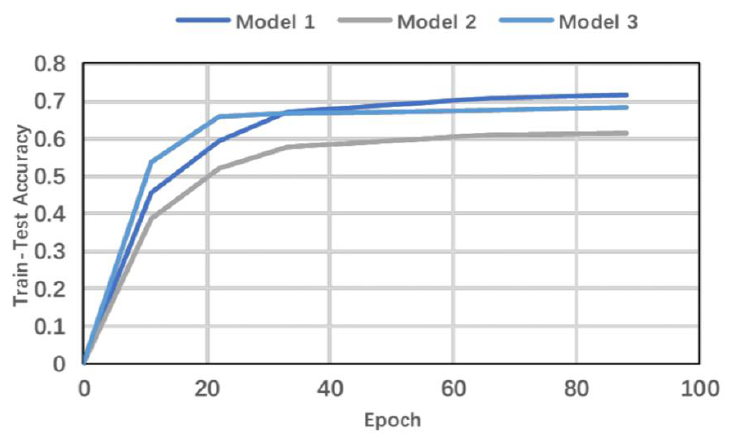
Figure 8. Variations in the training accuracy of three